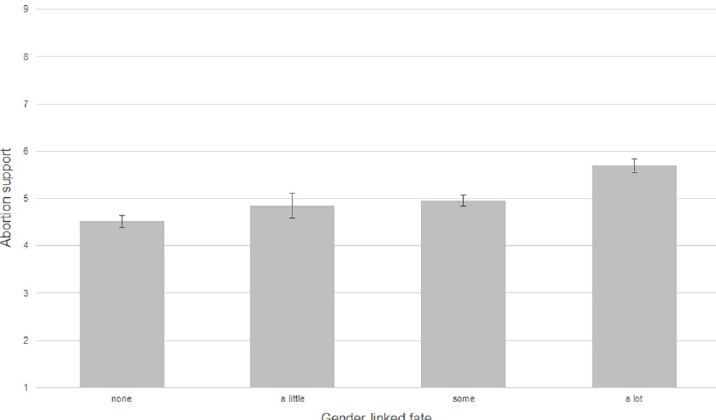
Fig 2. Gender linked fate and legal abortion support. Source: 2012 American National Election Study. r τ = 0.10, p < 0.001.